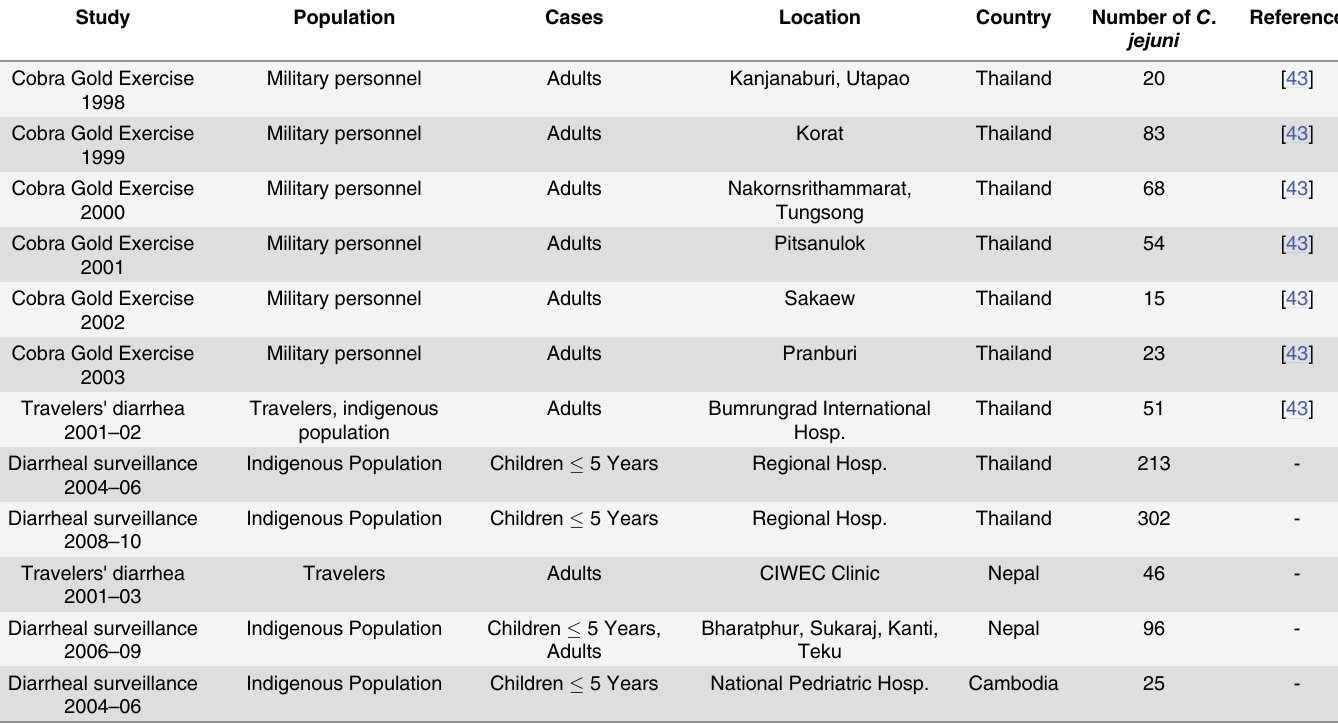
Table 2. Clinical strains used to test the multiplex PCR